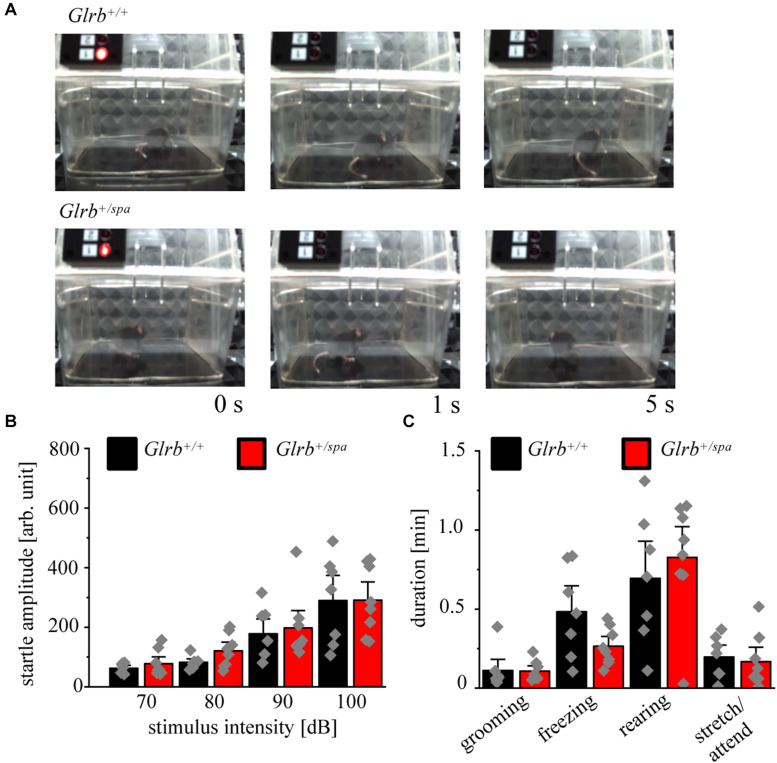
Heterozygous spastic mice lack enhanced startle responses. (A) Representative images of Glrb+/spa (n = 8, red bars) and Glrb+/+ (n = 7, black bars) animals during behavioral startle test. (B) Startle amplitudes of Glrb+/spa and Glrb+/+ animals during behavioral startle test using increased stimulus intensities (70–100 dB). (C) Times spent grooming, freezing, rearing, and stretch/attend of Glrb+/spa (n = 8, red bars) and Glrb+/+ (n = 7, black bars) animals during the startle test (time 1110 s). Data points are shown as gray color squares.